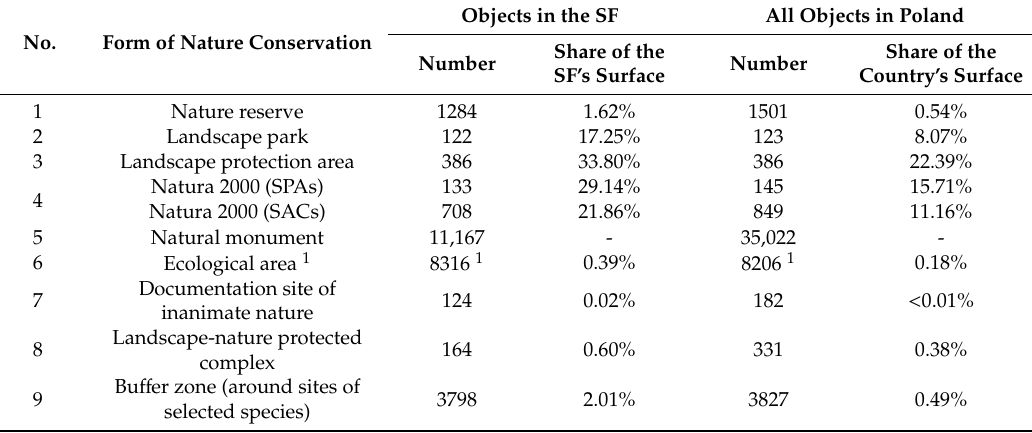
Table 1. Forms of nature conservation in the State Forests (SF) compared to Poland in general, at the end of 2018 (based on [24,27], and information from the General Directorate of Environmental